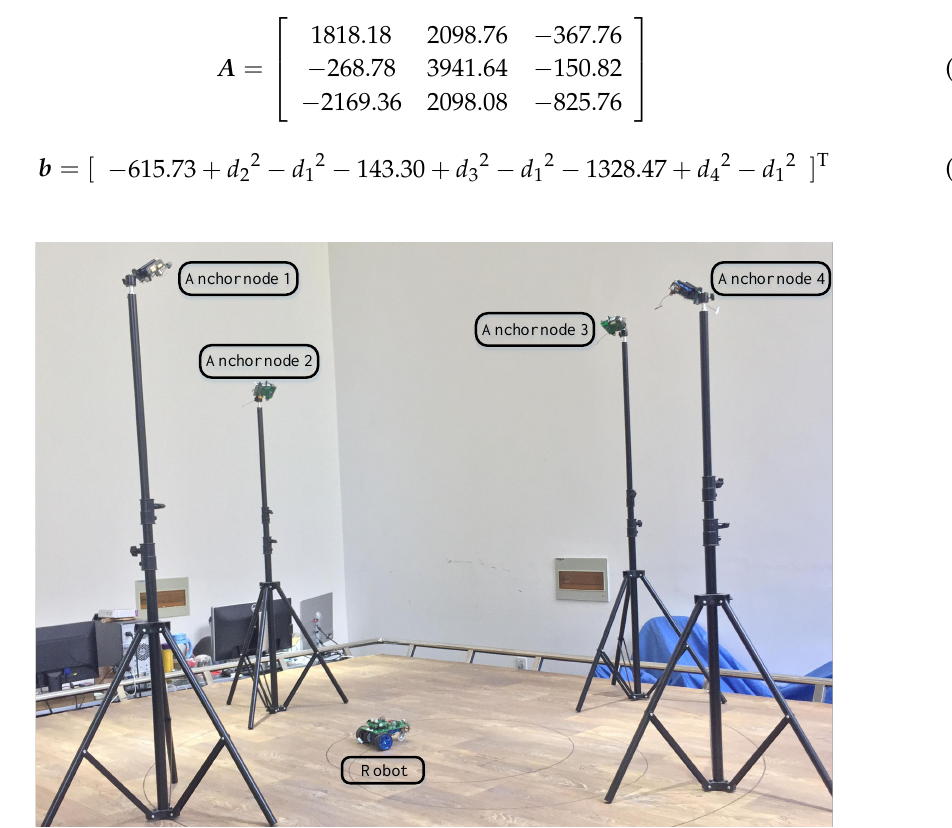
Figure 12. An illustration of the positioning experiment for the mobile